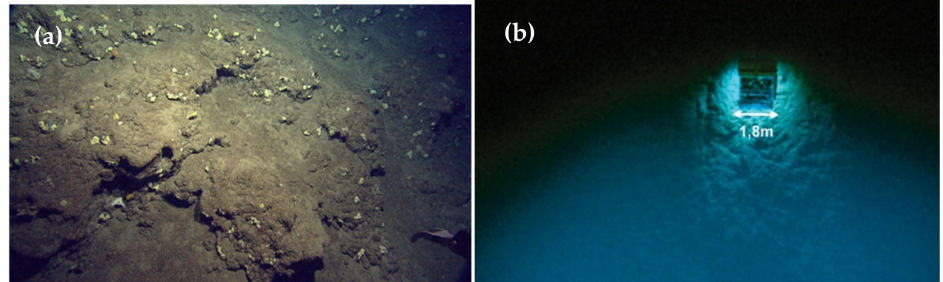
Figure 13. ( a ) Layered biogenic concreted rocks with their surface spotted with sponges at 204 m depth at the eastern flank of Yali volcano and ( b ) view showing the steep vertical northern flank of the volcanic dome, NE of Kondeliousa at 230 m